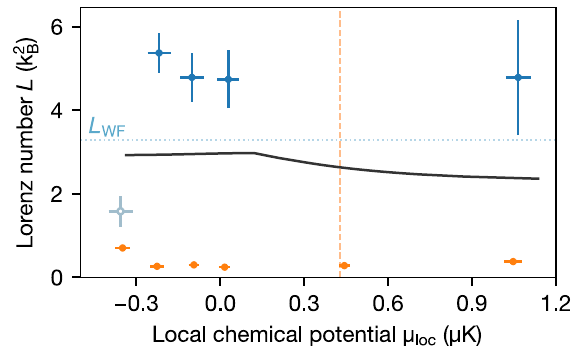
FIG. 4. Lorenz number L versus local chemical potential μ at loc the channel center. Fitted values in the noninteracting and strongly interacting regimes are shown as blue and orange points, respectively. The theoretical prediction based on Landauer theory is indicated by a solid black curve (Appendix E), and the π 2 = 3 · k 2 Wiedemann-Franz value L valid for degenerate WF ¼ B Fermi liquids is shown by a blue horizontal line. In the strongly interacting case, the vertical dashed line locates the superfluid transition inside the channel, while the reservoirs remain uncon- densed (Appendix B